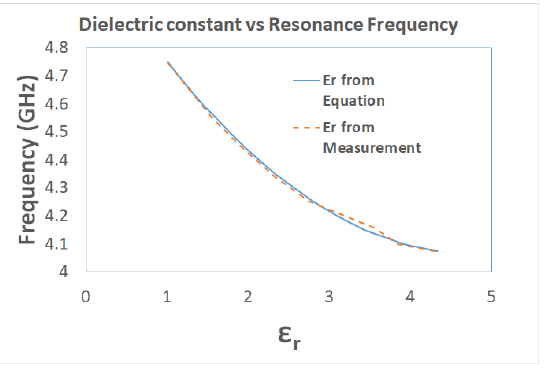
Figure 13. Comparison of resonance frequency vs Er calculated from equation and of known MUTs.